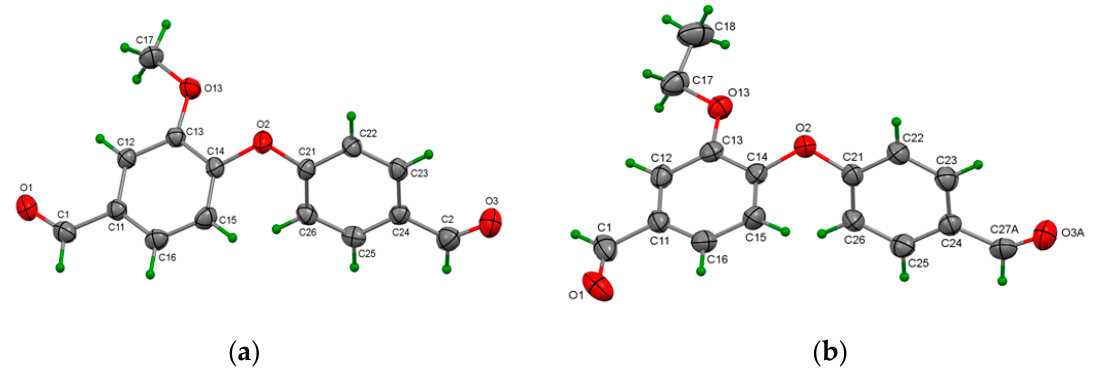
Figure 2. ( a ) ORTEP diagram of monomer 3b , and ( b ) ORTEP diagram of monomer 3c